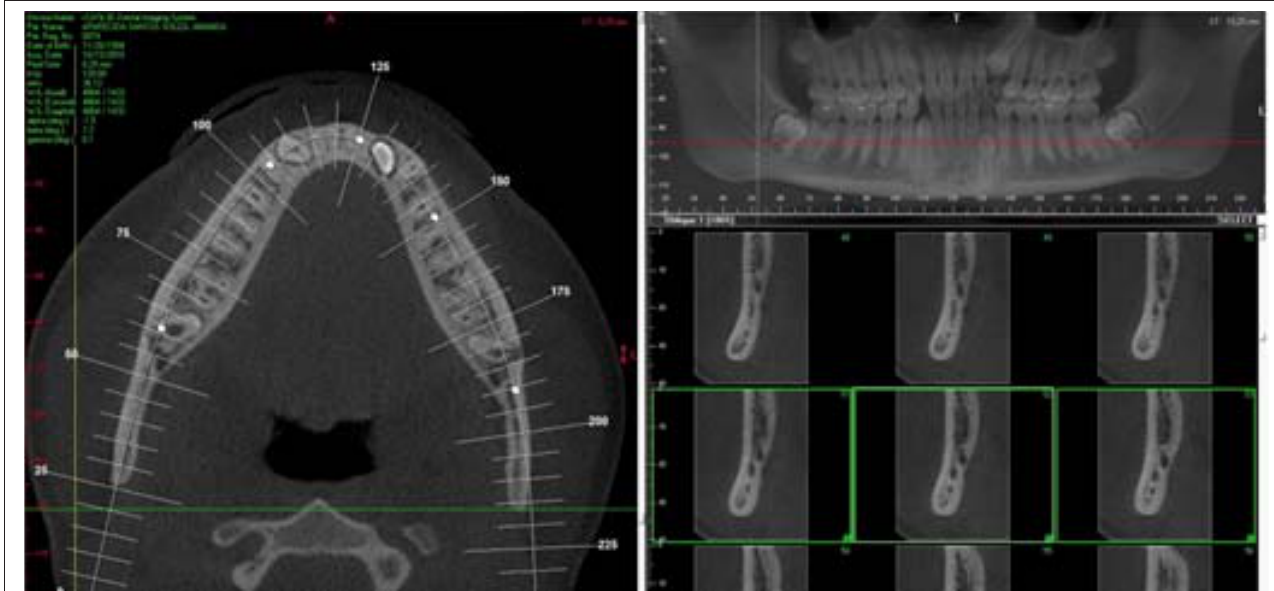
Fig. 1 - Illustration of the methods used to evaluate the CT images. A – Axial reconstruction tracing the jaw line to obtain the cross-sections; B – Panoramic reconstruction; C – Cross-sectional